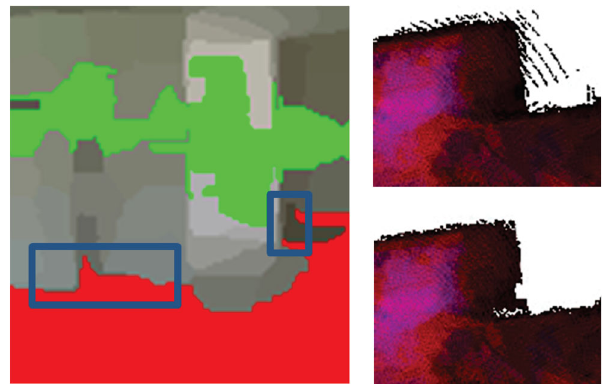
Fig. 6 Incorrect classification filtering. Left: detail of some misclassified super-pixels. Top right: the effect of transforming super- pixels without evaluating their reliability. Bottom right: overall results of merging the same area with our accumulation array ( D4 dataset 7, grid size 4